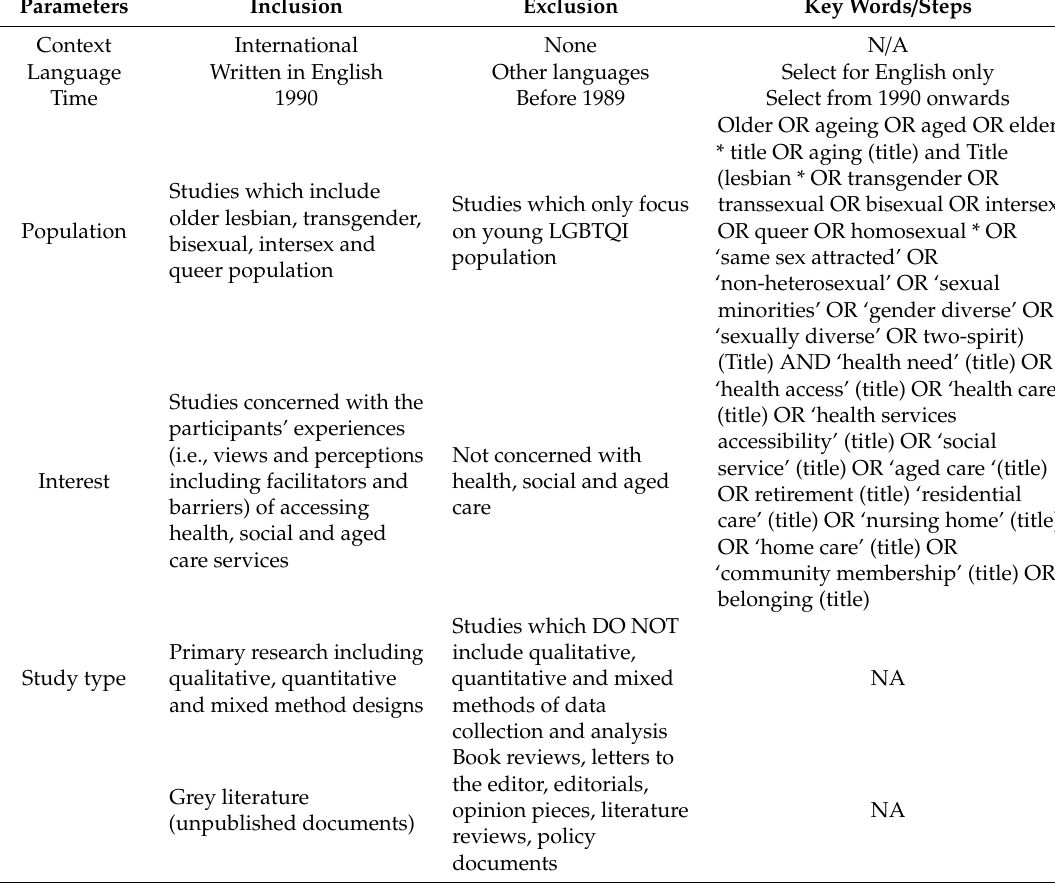
Table 1. Summary of the inclusion / exclusion criteria and